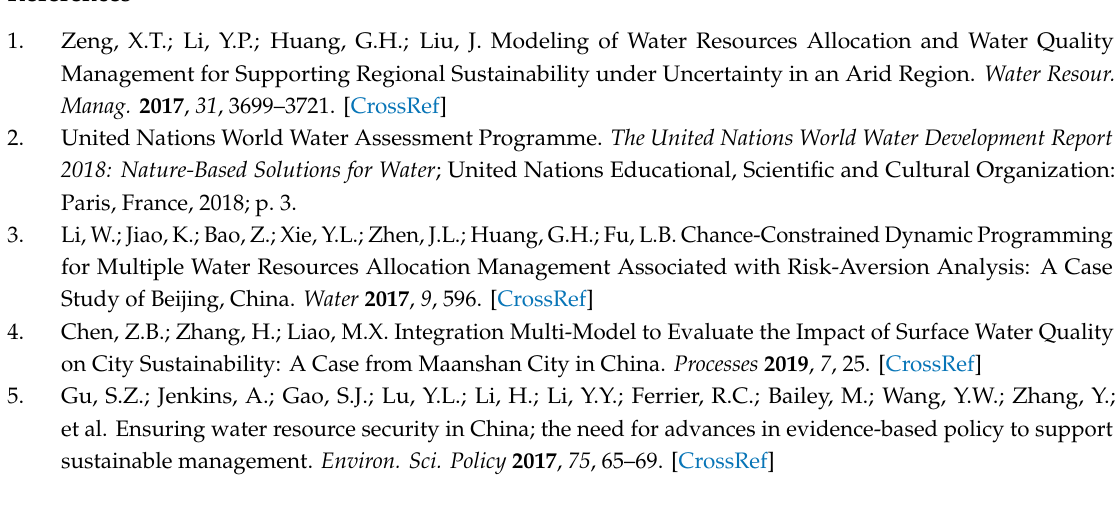
Figure B2. The function images of y (cid:2869) = 6625𝑘 (cid:2870) + 26659𝑘 + 10282 and y (cid:2870) = 10275𝑘 (cid:2870) + 33291𝑘 .